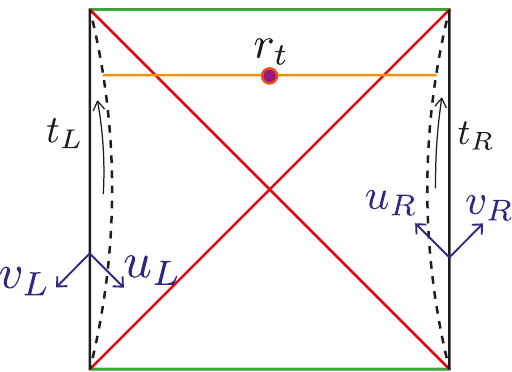
Figure 1. Penrose diagram for AdS 2 . The boundary r = R b , corresponding to some fixed value of the dilaton φ = φ b , is indicated by a dashed black line. The times t L = t R run upwards along both boundaries. The axis of changing u , v are indicated in the figure. We have also illustrated L/R L/R a geodesic with turning point r t (see